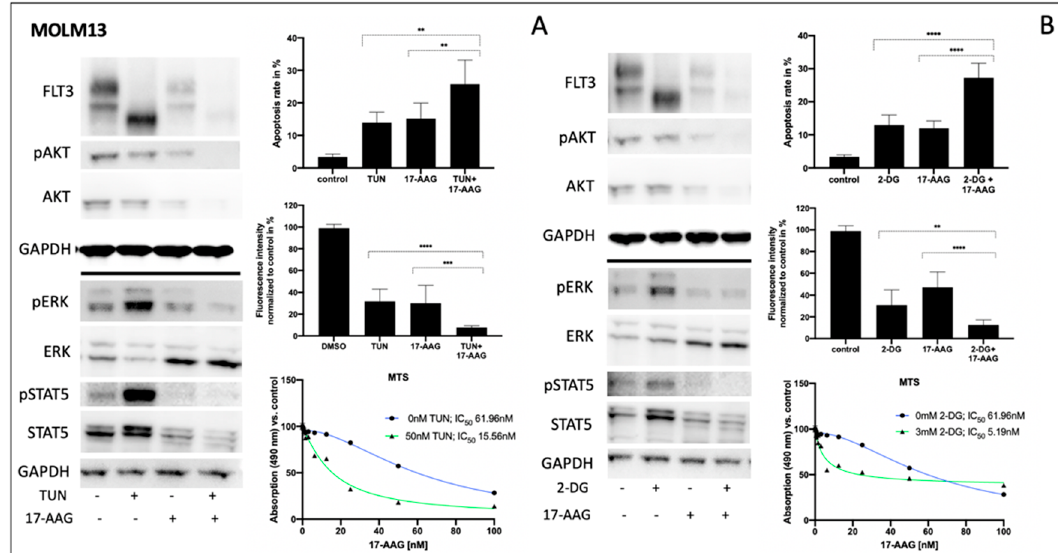
Figure 3. Impact of tunicamycin or 2-deoxy-D-glucose on signal transduction, apoptosis, and proliferation of human FLT3- ITD-expressing MOLM13 cells. Human FLT3-ITD expressing MOLM13 cells were pre-treated for indicated combinations either with 50 nM tunicamycin ( A ) or 3 mM 2-deoxy-D-glucose ( B ) for 24 h after 75 nM 17-AAG was added to the wells for further 24 h. The protein lysates were subjected to immunoblotting to assess changes of indicated signalling proteins. For loading control, levels of GAPDH were detected. The corresponding apoptosis rates are shown after the cells were stained with Annexin V and subsequently analyzed by flow cytometry (upper right of A and B ). For same conditions, a PrestoBlue viability assay was carried out and the dataset that is normalized to the control is illustrated (center right A and B ). IC 50 values are indicated for 17-AAG dependence on different concentrations of pre-treatment with tunicamycin and 2-deoxy-D-glucose (lower right, A and B ) . Student’s t -test was used for calculating the statistical significance (**** p < 0.0001, *** p < 0.001, ** p < 0.01, ns not significant). The data for the MTS assays are shown as relative absorption compared to untreated controls. The histograms provide representative data of triplicates that were reproduced in three independent experiments. (mean values and ± SD). The replicates are shown in the Supplement Table S3.